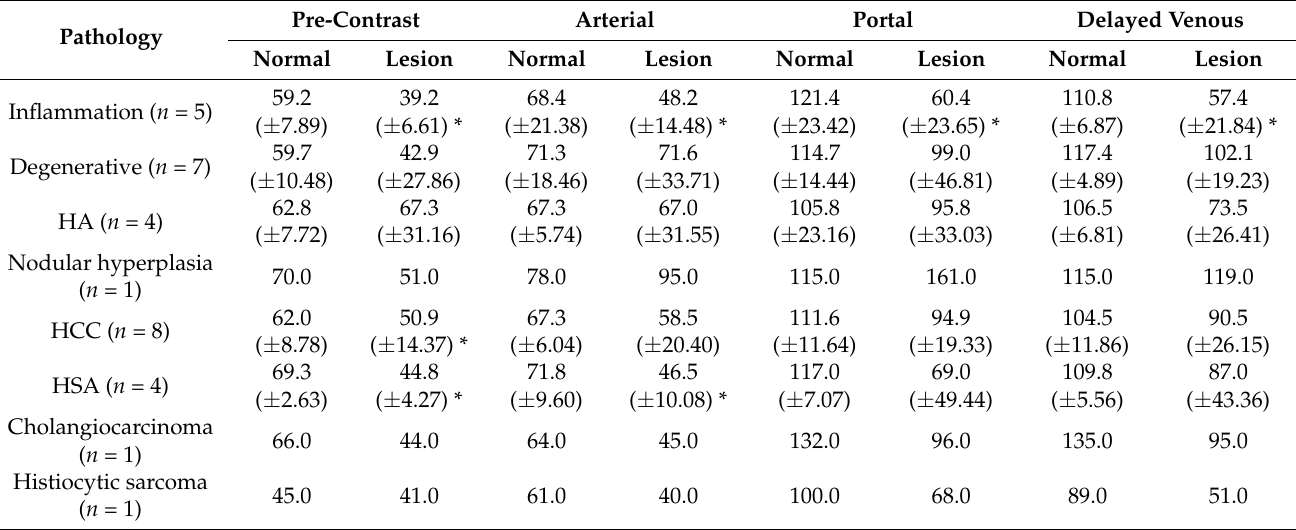
Table 2. Mean ( ± SD) attenuation values (HU) of the normal liver parenchyma and the lesion in the different phases of TP-MDCT.